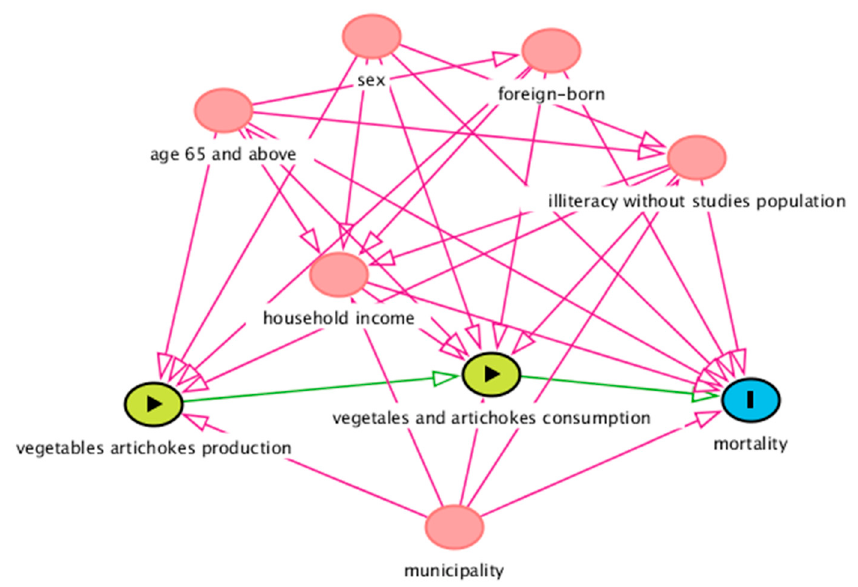
Figure 2. Directed Acyclic Graph (DAG) of the effect of vegetable and artichoke production and consumption (exposure) on mortality (outcome). Ancestors of exposure and outcome (red color). Based on DAGitty version 3.0. ( Johannes Textor, Nijmegen, The Netherlands).